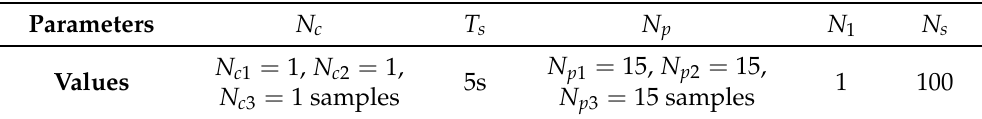
Table 2. Parameters for the MPC.